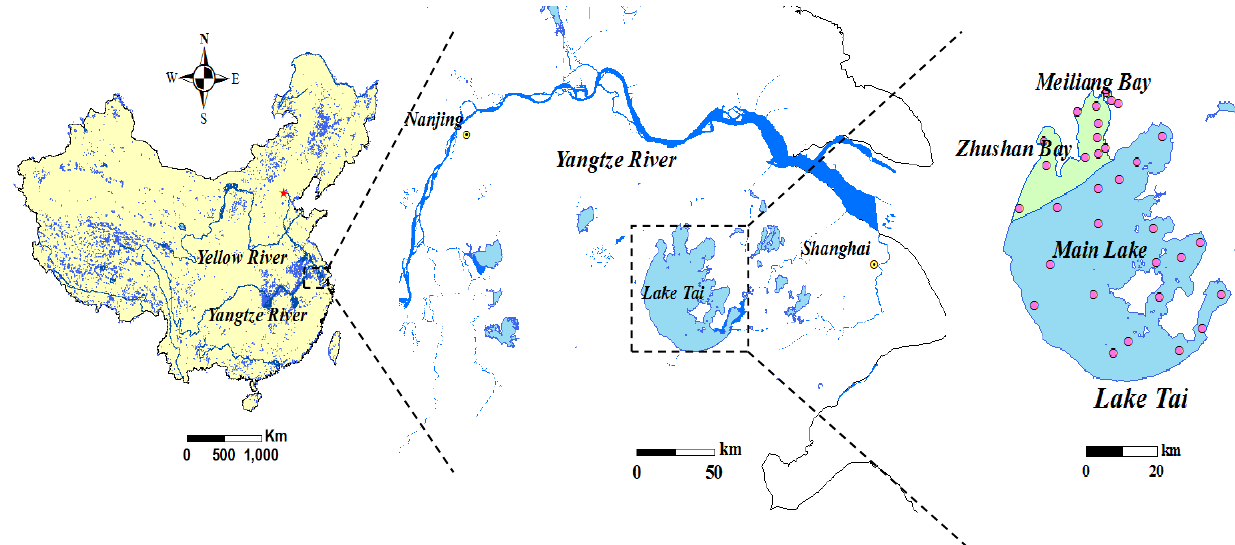
Figure 1. Map showing the location of Lake Tai and its subdivisions. Data collection sites are shown in the map on the right hand